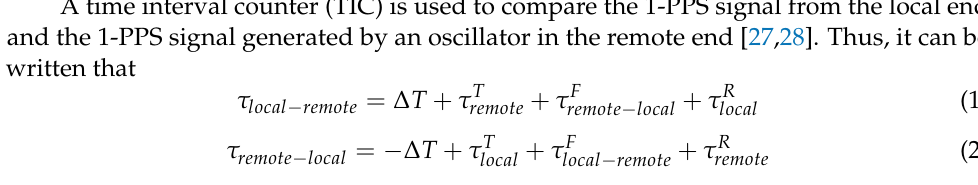
Figure 1. Timing sequence diagram based on the dense wavelength division multiplexing of bidirec- tional optical fiber time